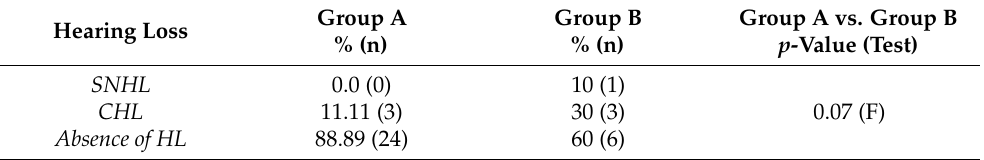
Table 4. Types of hearing loss of COVID-19 children.